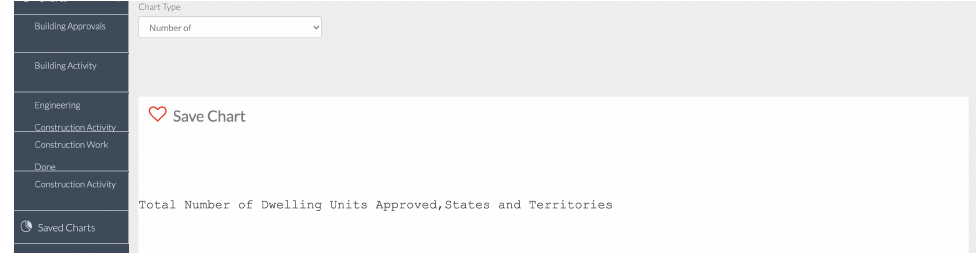
Figure 5. Main navigation and saved